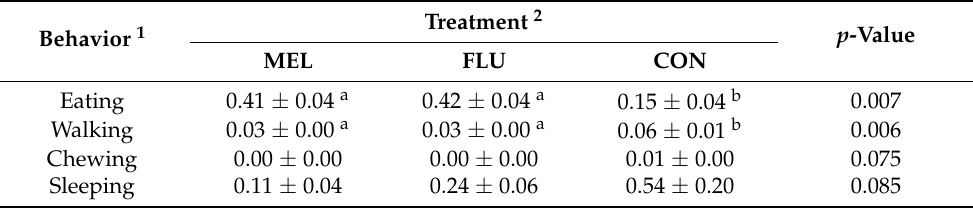
Table 2. Proportion of time sheep were engaged in specific behaviors ( n = 12 sheep per analgesia group; n = 6 controls) post-surgery. Values represent the proportional means ( ± SEM).